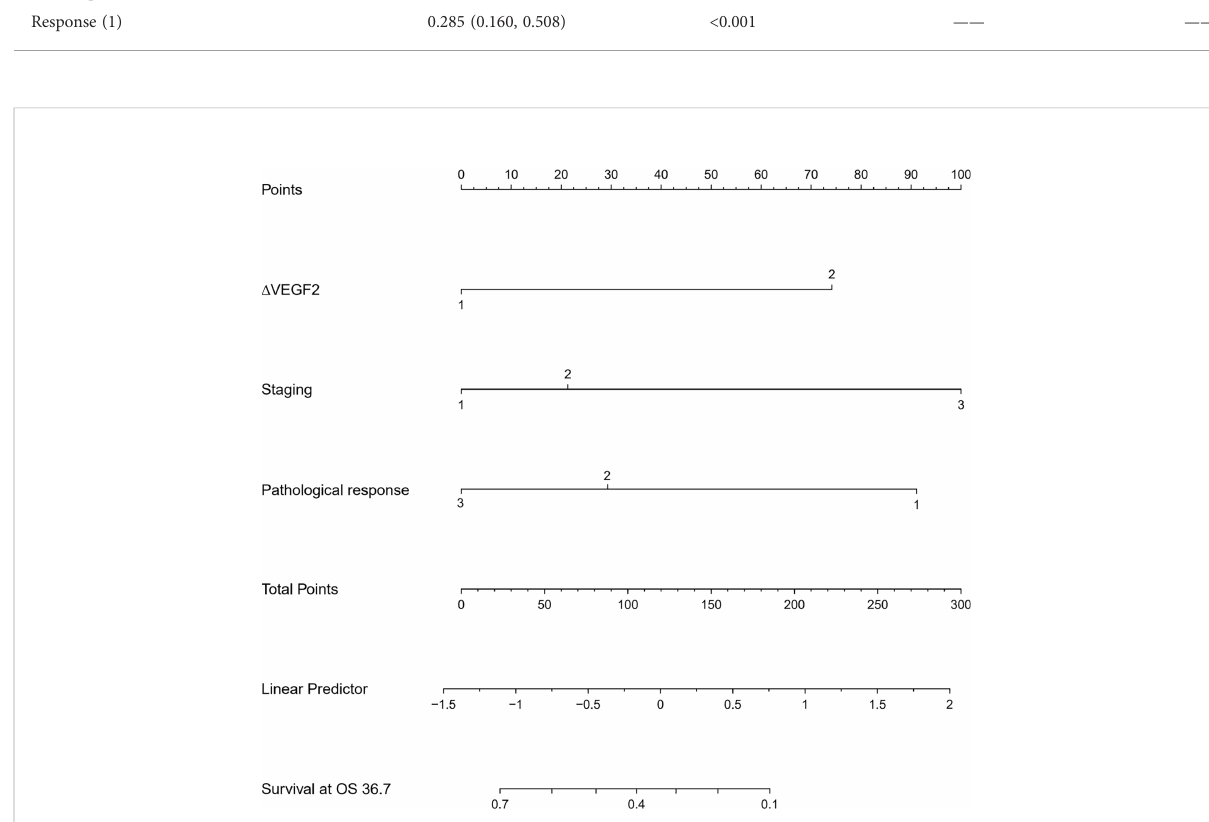
FIGURE 5 The nomogram for predicting the overall survival of patients with non-surgical